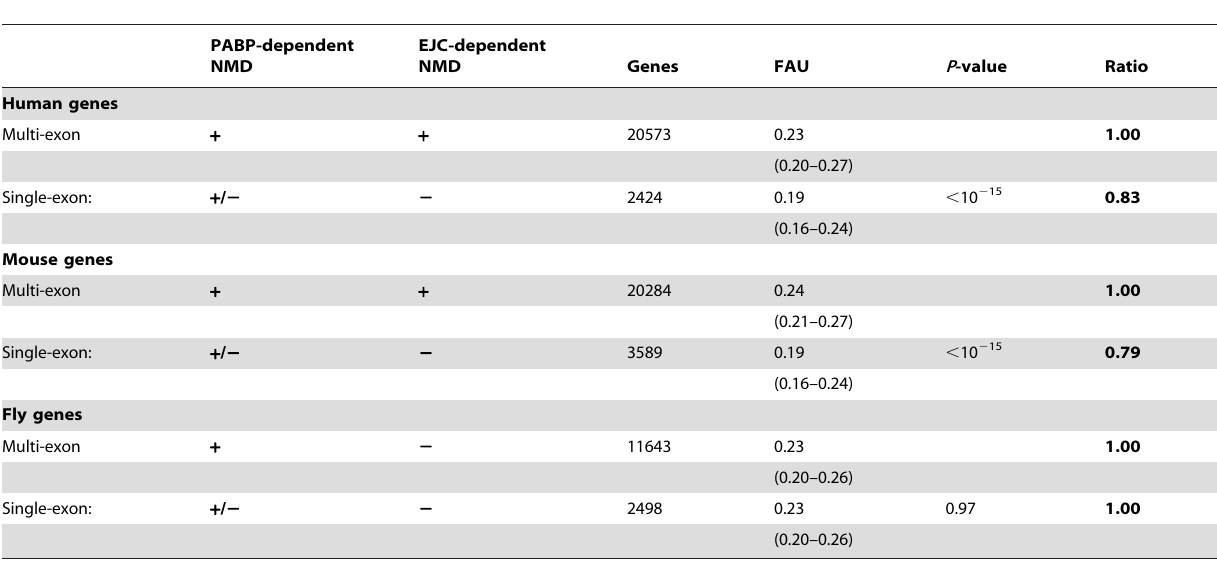
Table 2. Fragile amino acid usage (FAU) of proteins encoded by multi-exon genes and single-exon genes in the human, mouse, and fly genomes.